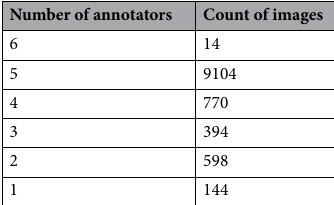
Table 1. The number of images that were annotated by a specific number of annotators. e.g., we had 9104 images with 5 annotators each, and 770 with 4 annotators